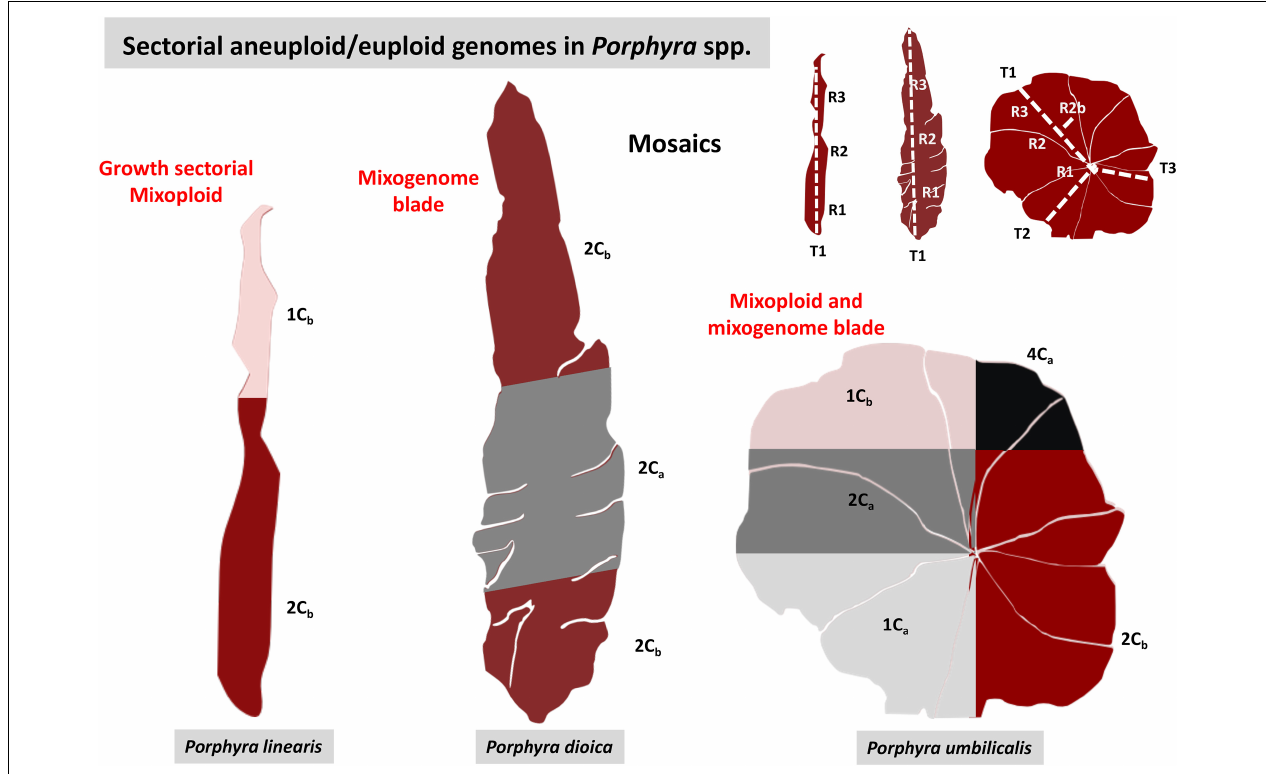
FIGURE 4 | Diagrams showing examples of the distribution of genome sizes along the thalli for each Porphyra species. In P. linearis , the example shows two main sectors, the larger genome sizes on the bottom part of the blade and the smaller genome sizes on the top. In P. umbilicalis and P. dioica genome sizes are distributed randomly but in mosaics. On the right corner, the diagram shows the thallus portions analyzed in the different transects along the blade.